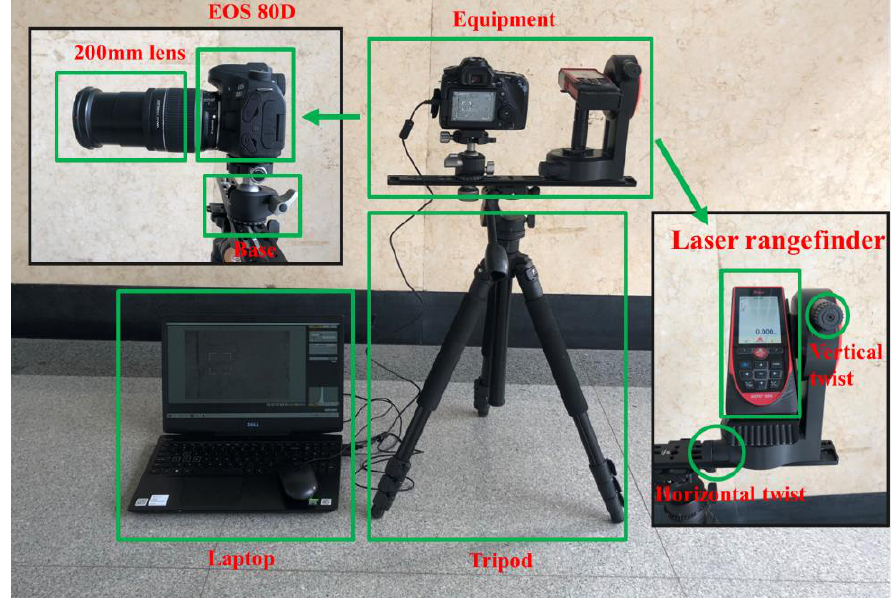
Figure 3. Crack measurement equipment composed of camera, laser rangefinder, laptop and tri- pod.